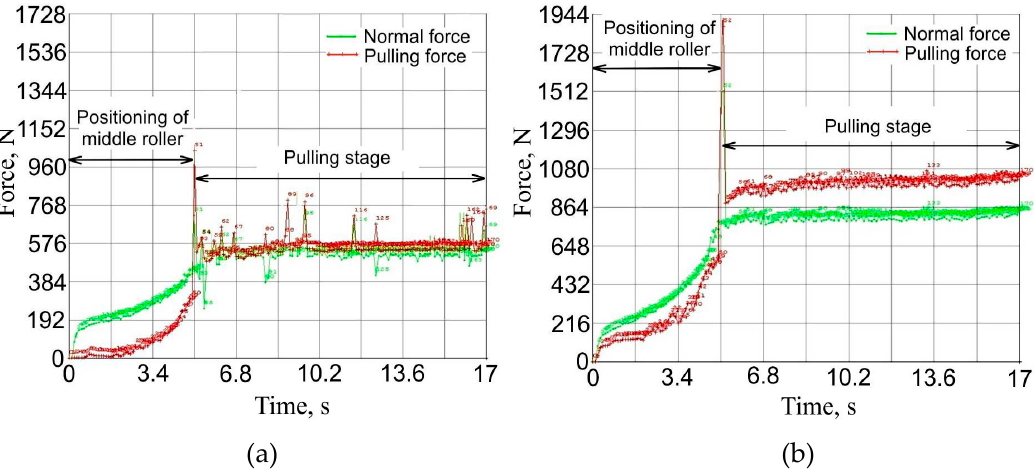
Figure 10. Numerically predicted variation of the drawing and normal force for a specimen pulled to flow by a system of ( a ) rotatable and ( b ) fixed rollers for height of drawbead h = 12 mm and specimen width w = 20 mm.